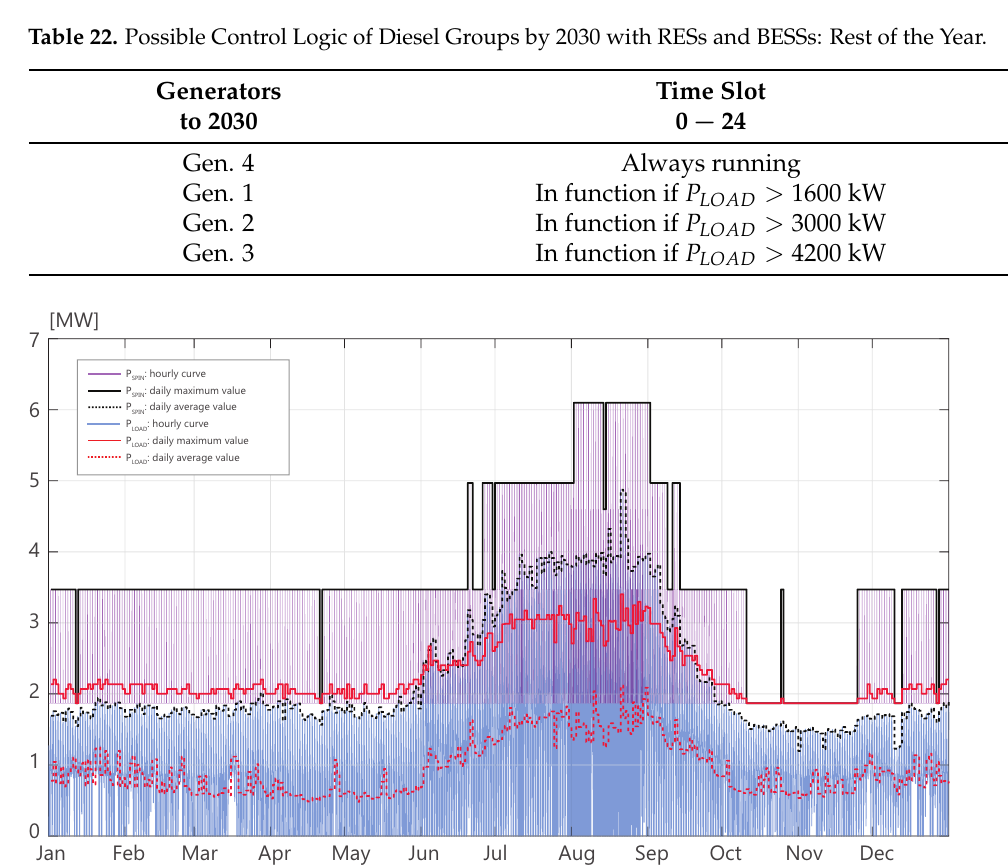
Figure 24. Hourly curve of spinning power P SPIN and load power P LOAD expected by 2030 with the integration of RESs and BESSs equal to 300% of the objectives of the